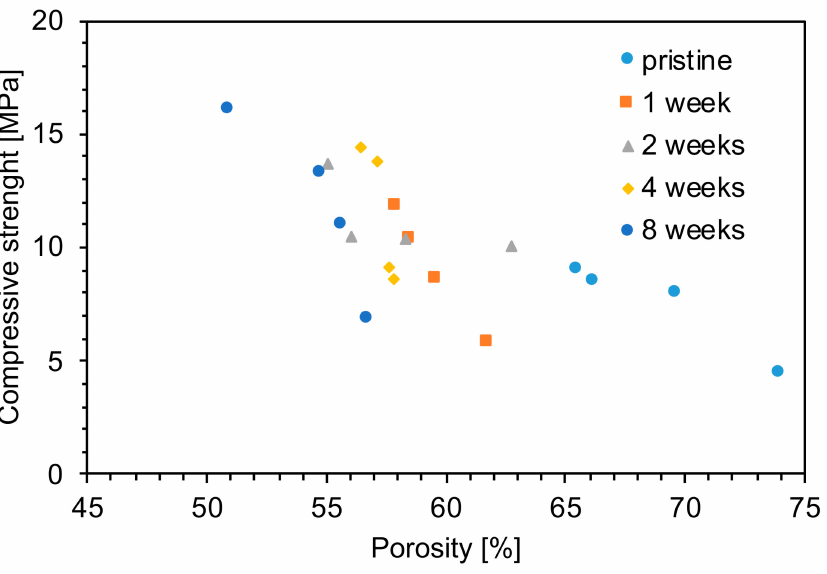
Figure 12. Compression strength as a function of porosity for foams aged at di ff erent